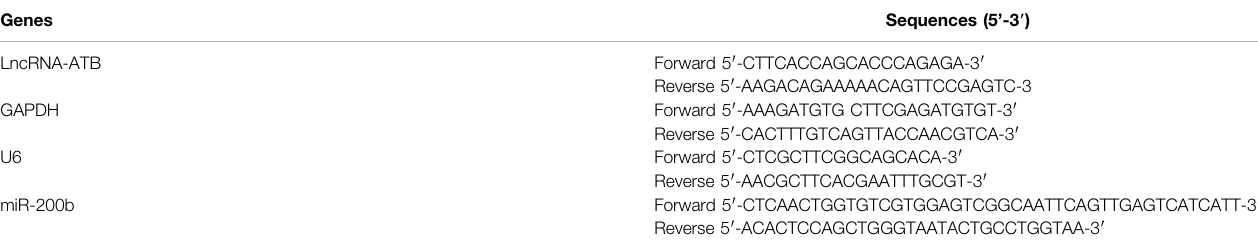
TABLE 1 | Primer sequences used in the RT-PCR assay.